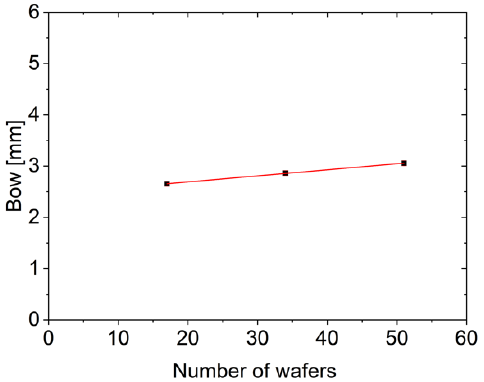
Figure 8. Bow measurements in dependence of the variation of the number of wafers (y = 0.012 ( ± 0.001 ) x + 2.46 ( ± 0.01 ) , COD (coe ffi cient of determination) (r 2 ): 0.99).